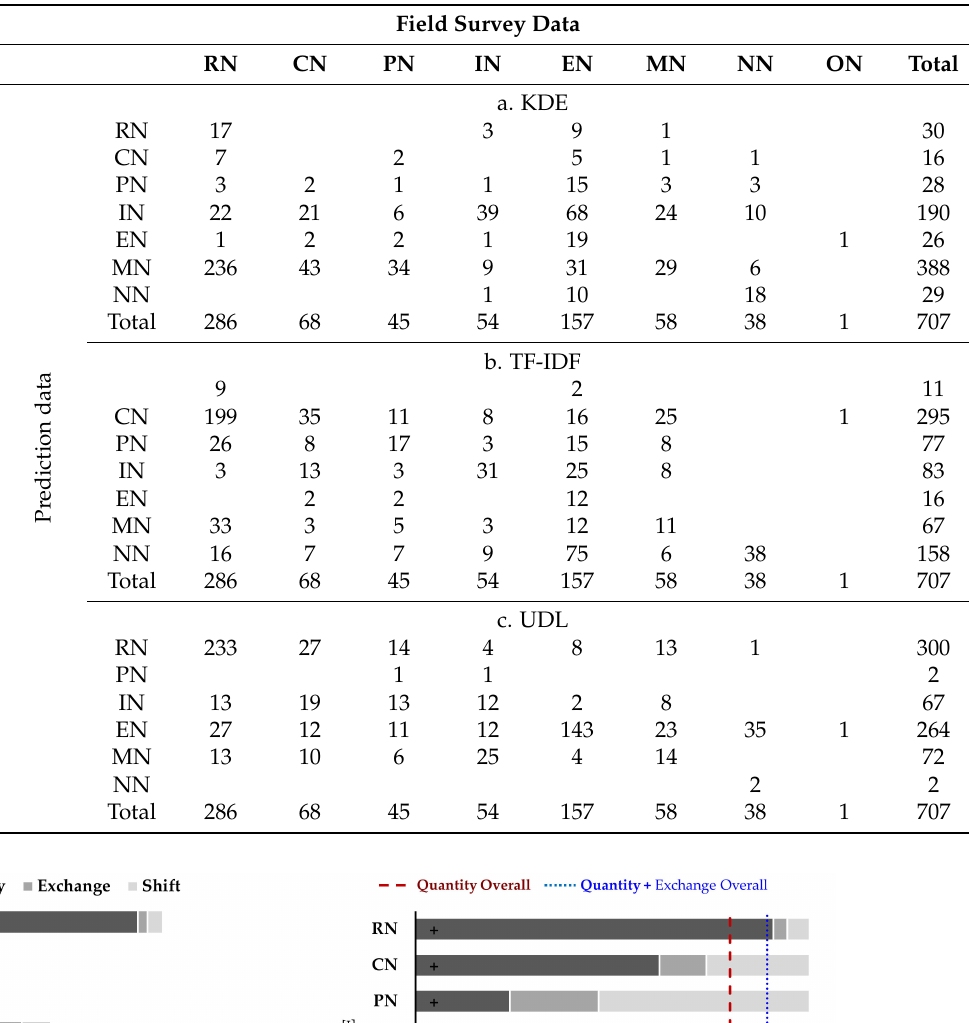
Table 3. Verification confusion matrix of functional zones.